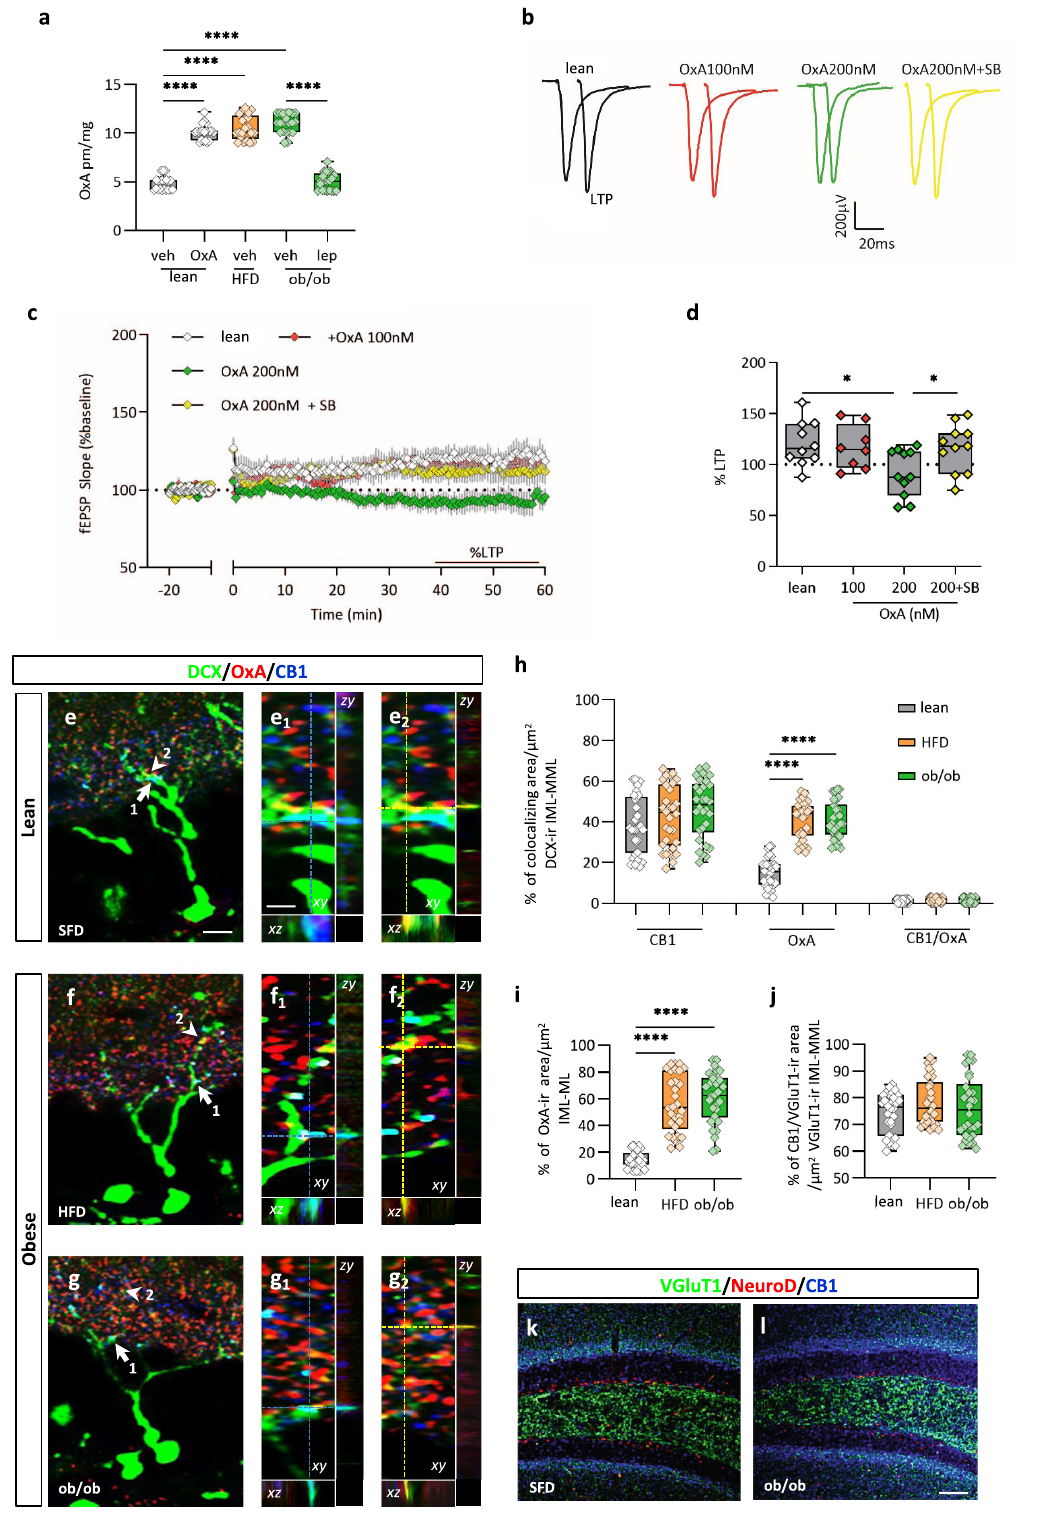
OxA elicits 2-AG biosynthesis at ML-DG synapses . As it was previously demonstrated, DG newborn neurons express a func- tional eCBs system 31 – 33 . To investigate the putative existence of the anatomical substrate underlying the eCBs and OxA interplay at the ML of DG, we fi rst performed a confocal study of multiple DCX/OxA/CB1 immunolabeling, in lean and obese mice. A wide density of distribution of CB1/DCX-ir puncta was found in the